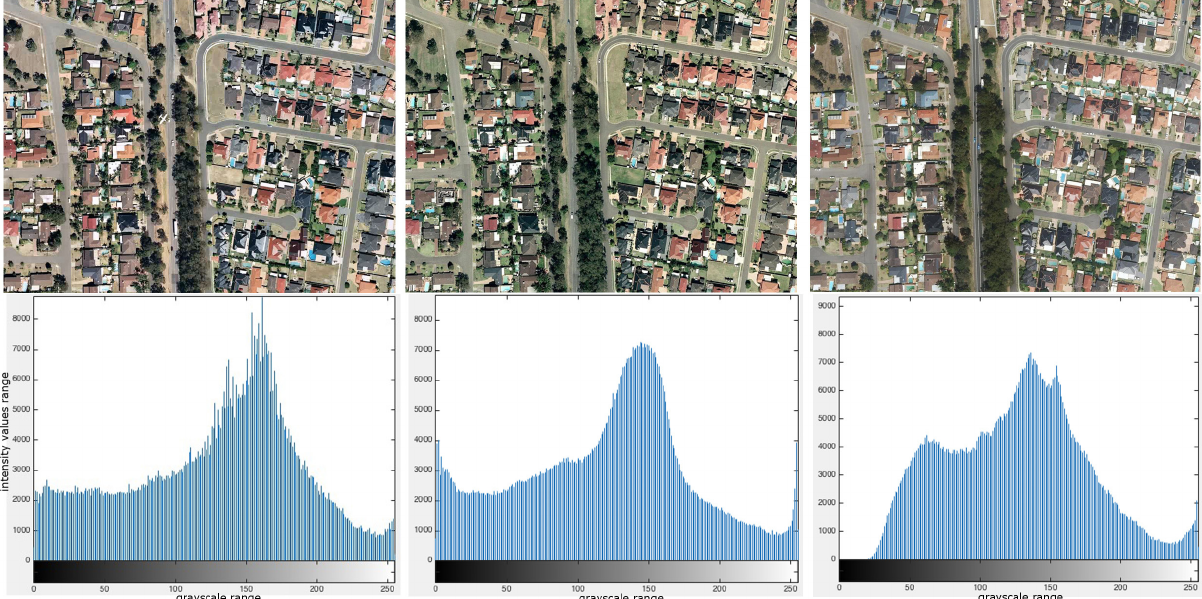
Figure 12: Combined histograms of the frame #1 from Datasets 2007, 2009, 2014 correspondingly.